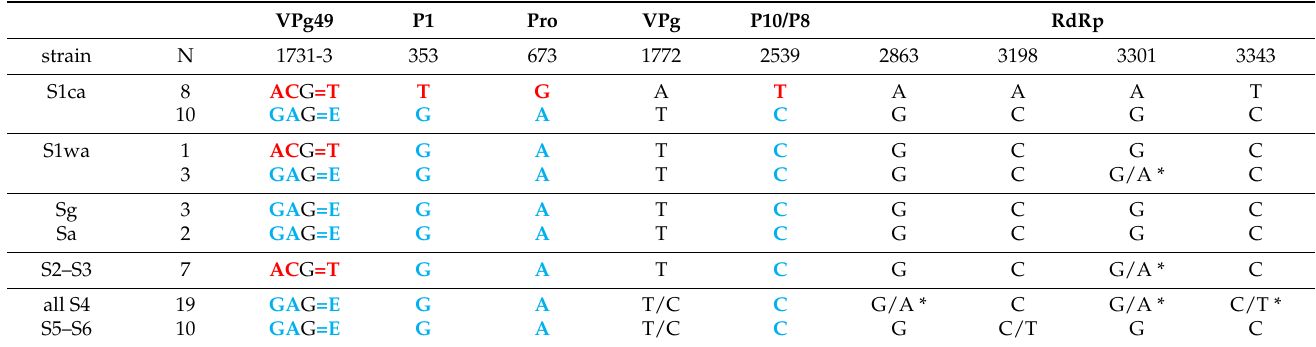
Table 1. Nucleotidic polymorphisms specific to E/T/T’ pathotypes. For each strain, N isolates were grouped, depending on their polymorphisms at positions 1731–1733 (codons ACG or GAG), corresponding to VPg49 (glutamic acid E or threonine T, respectively). Nucleotides at the candidate sites identified by DNAsp were indicated. Polymorphic sites specific to pathotypes were bolded and colored in red (T or T’ specificity) or blue (E specificity).